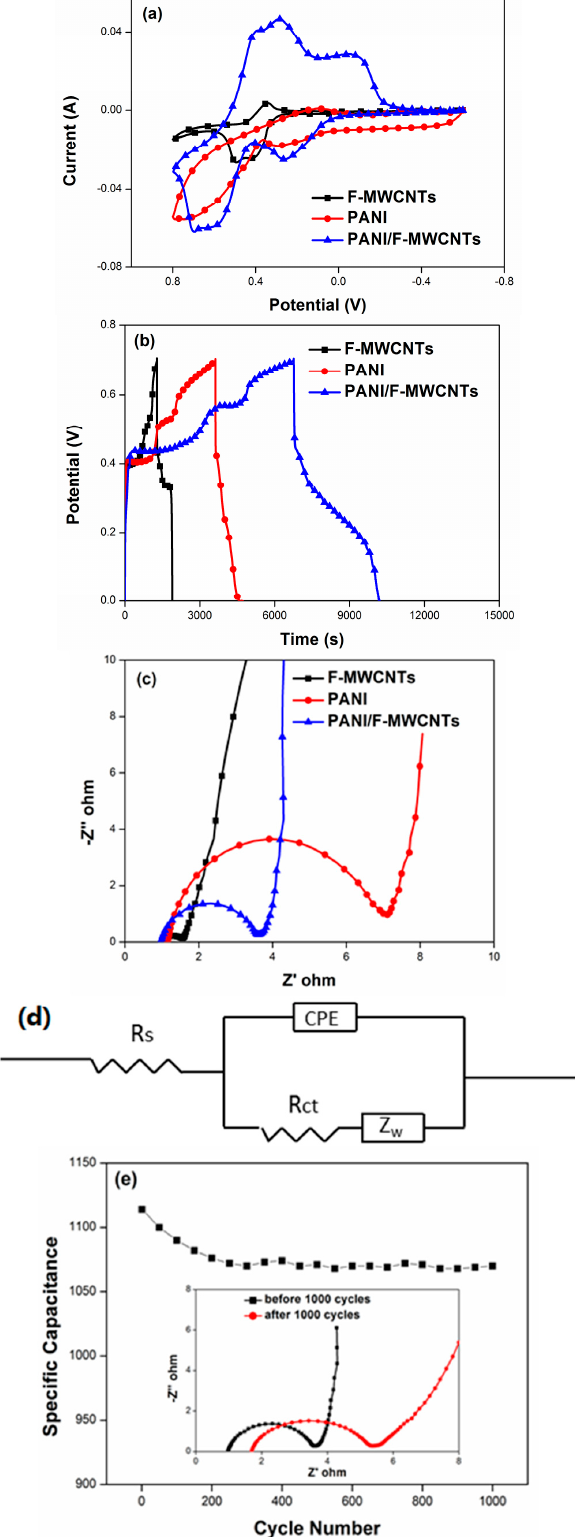
Figure 4. Electrochemical test results of PANI/A-MWCNTs, PANI, and A-MWCNTs in 2 M HQ-1 M H 2 SO 4 electrolytes. ( a ) CV results at a scan rate of 5 mV/s; ( b ) GCD results at a current density of 0.5 A/g; ( c ) EIS results; ( d ) equivalent circuit; and ( e ) cycling stability of PANI/A-MWCNTs at a current density of 10 A/g; Inset: Nyquist plot of PANI/A-MWCNTs before and after cycling stability test.